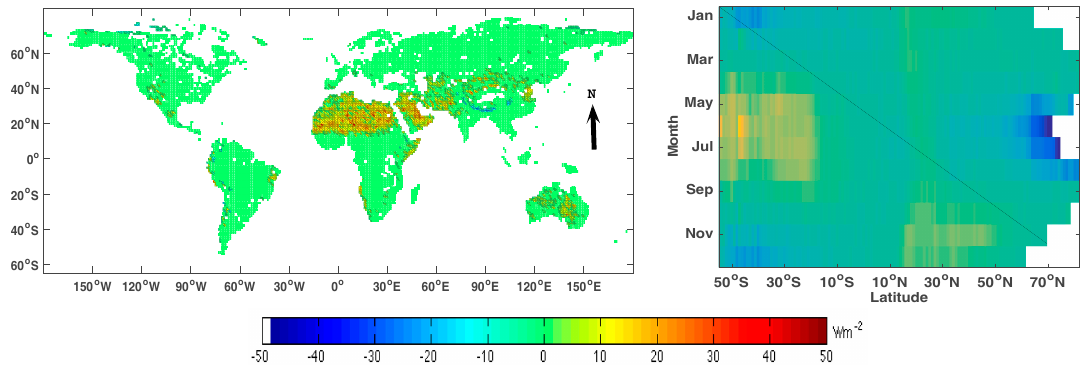
Figure 9. Comparison of MODIS net-radiation with corresponding estimates from CERES: ( left ) the difference between mean daily net-radiation from MODIS and CERES; and ( right ) (Hovmoller diagram) the monthly latitudinal distribution of difference between mean net-radiation from MODIS and